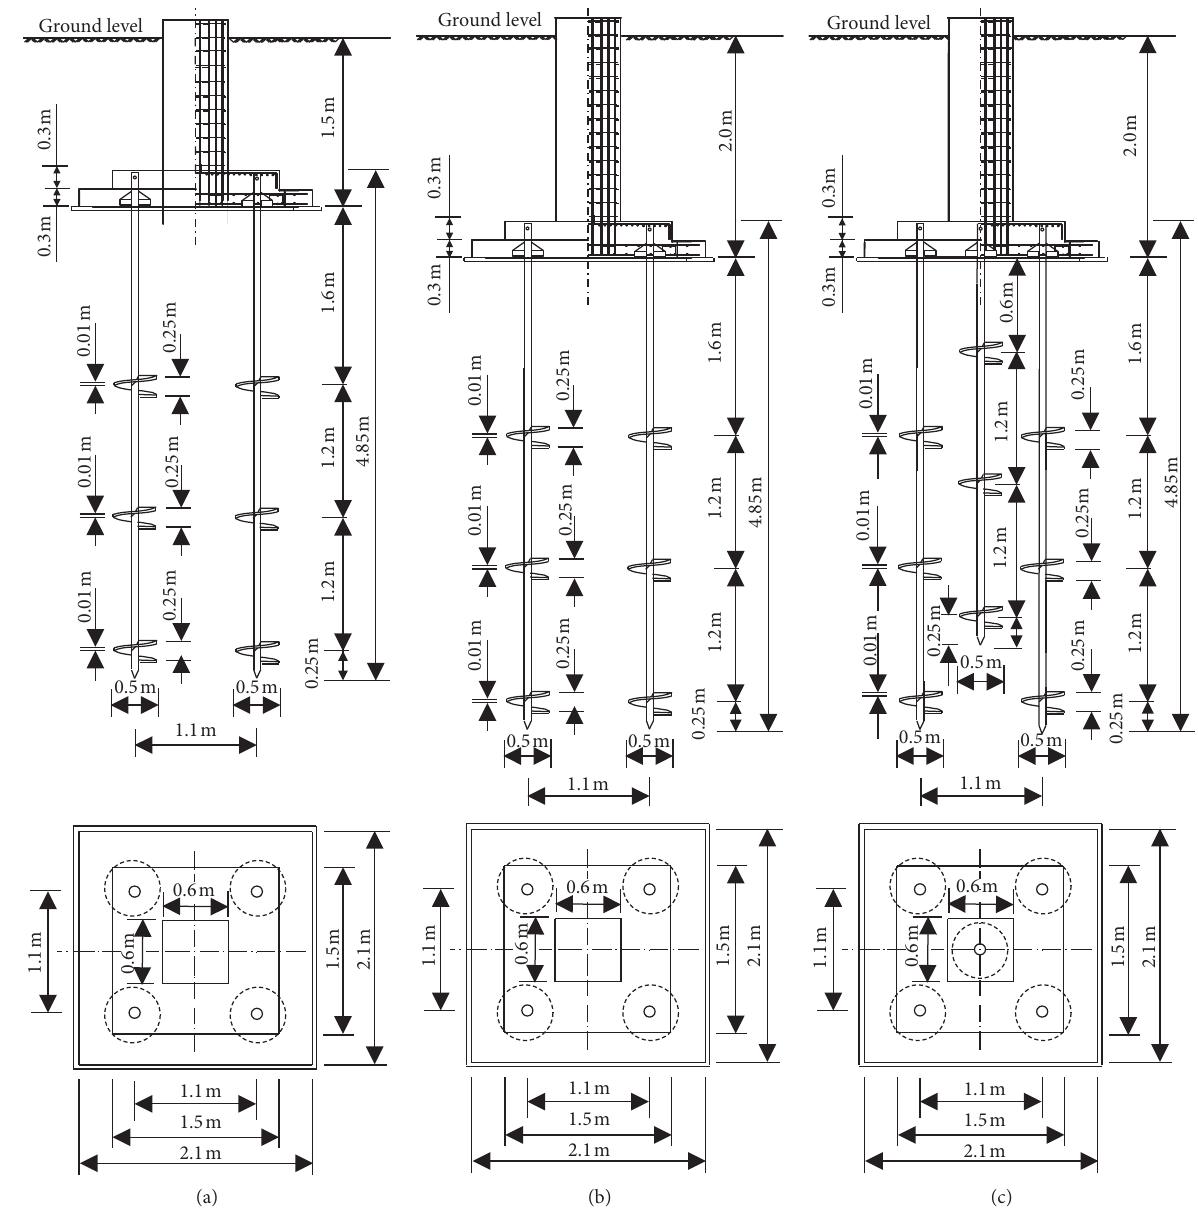
Figure 3: Details of composite foundations in the test: (a) CF1, (b) CF2, and (c) CF3.